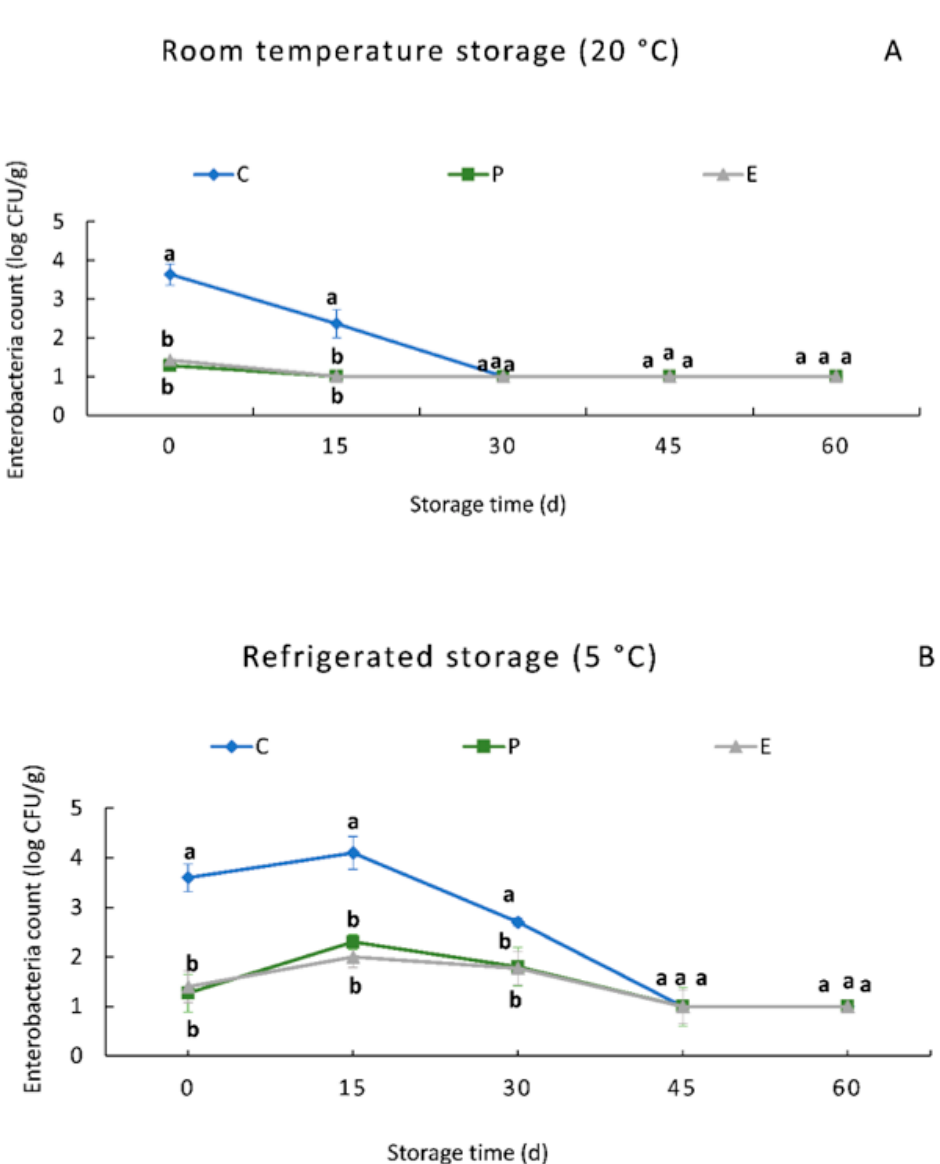
Figure 6. ( A ): Enterobacteria counts (means ± standard deviations) during 60 d of room temperature storage (20 °C) of Salamines Criollos formulated with microencapsulated L. plantarum BFL (E) and free L. plantarum BFL (P). ( B ): Enterobacteria counts (means ± standard deviations) during 60 d of refrigerated storage (5 °C) of Salamines Criollos formulated with microencapsulated L. plantarum BFL (E) and free L. plantarum BFL (P). The different letters indicate significant differences between treatments on the same day under the same storage temperature.